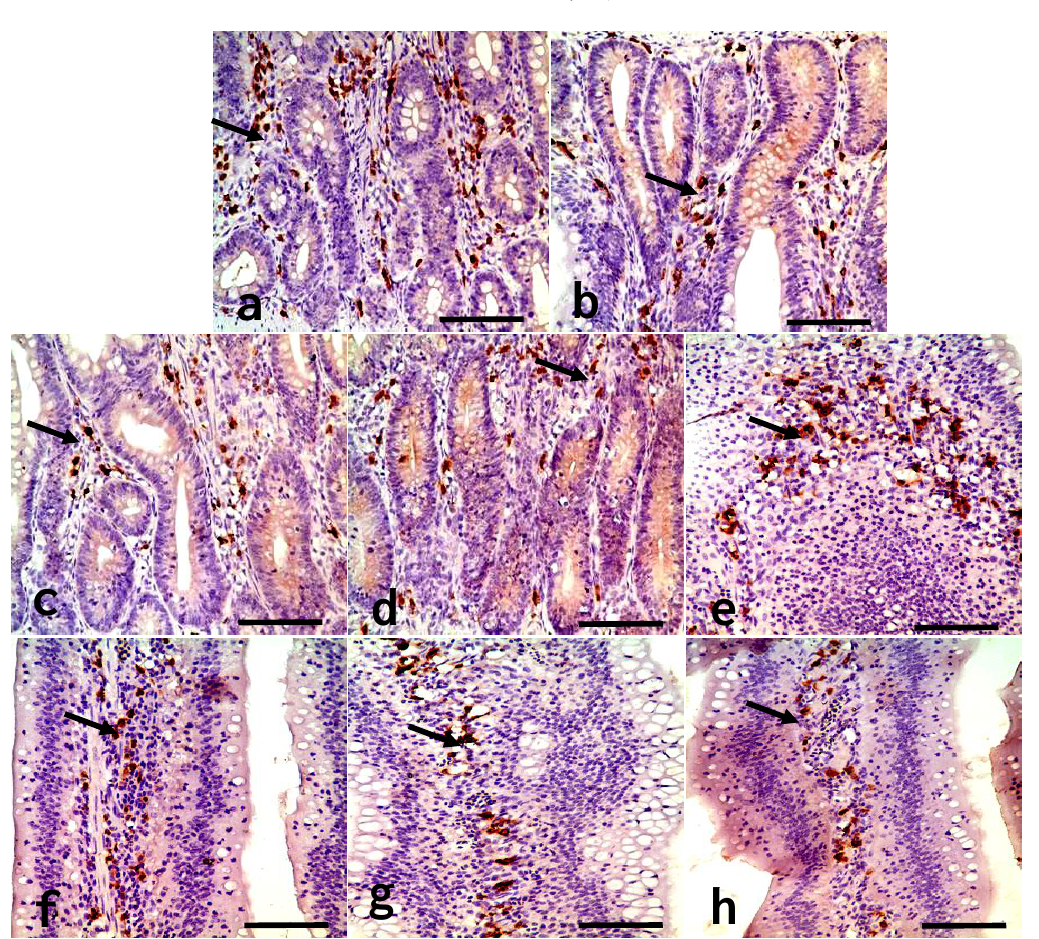
propria in the 900 mg/kg group. (SABC, bar = 50